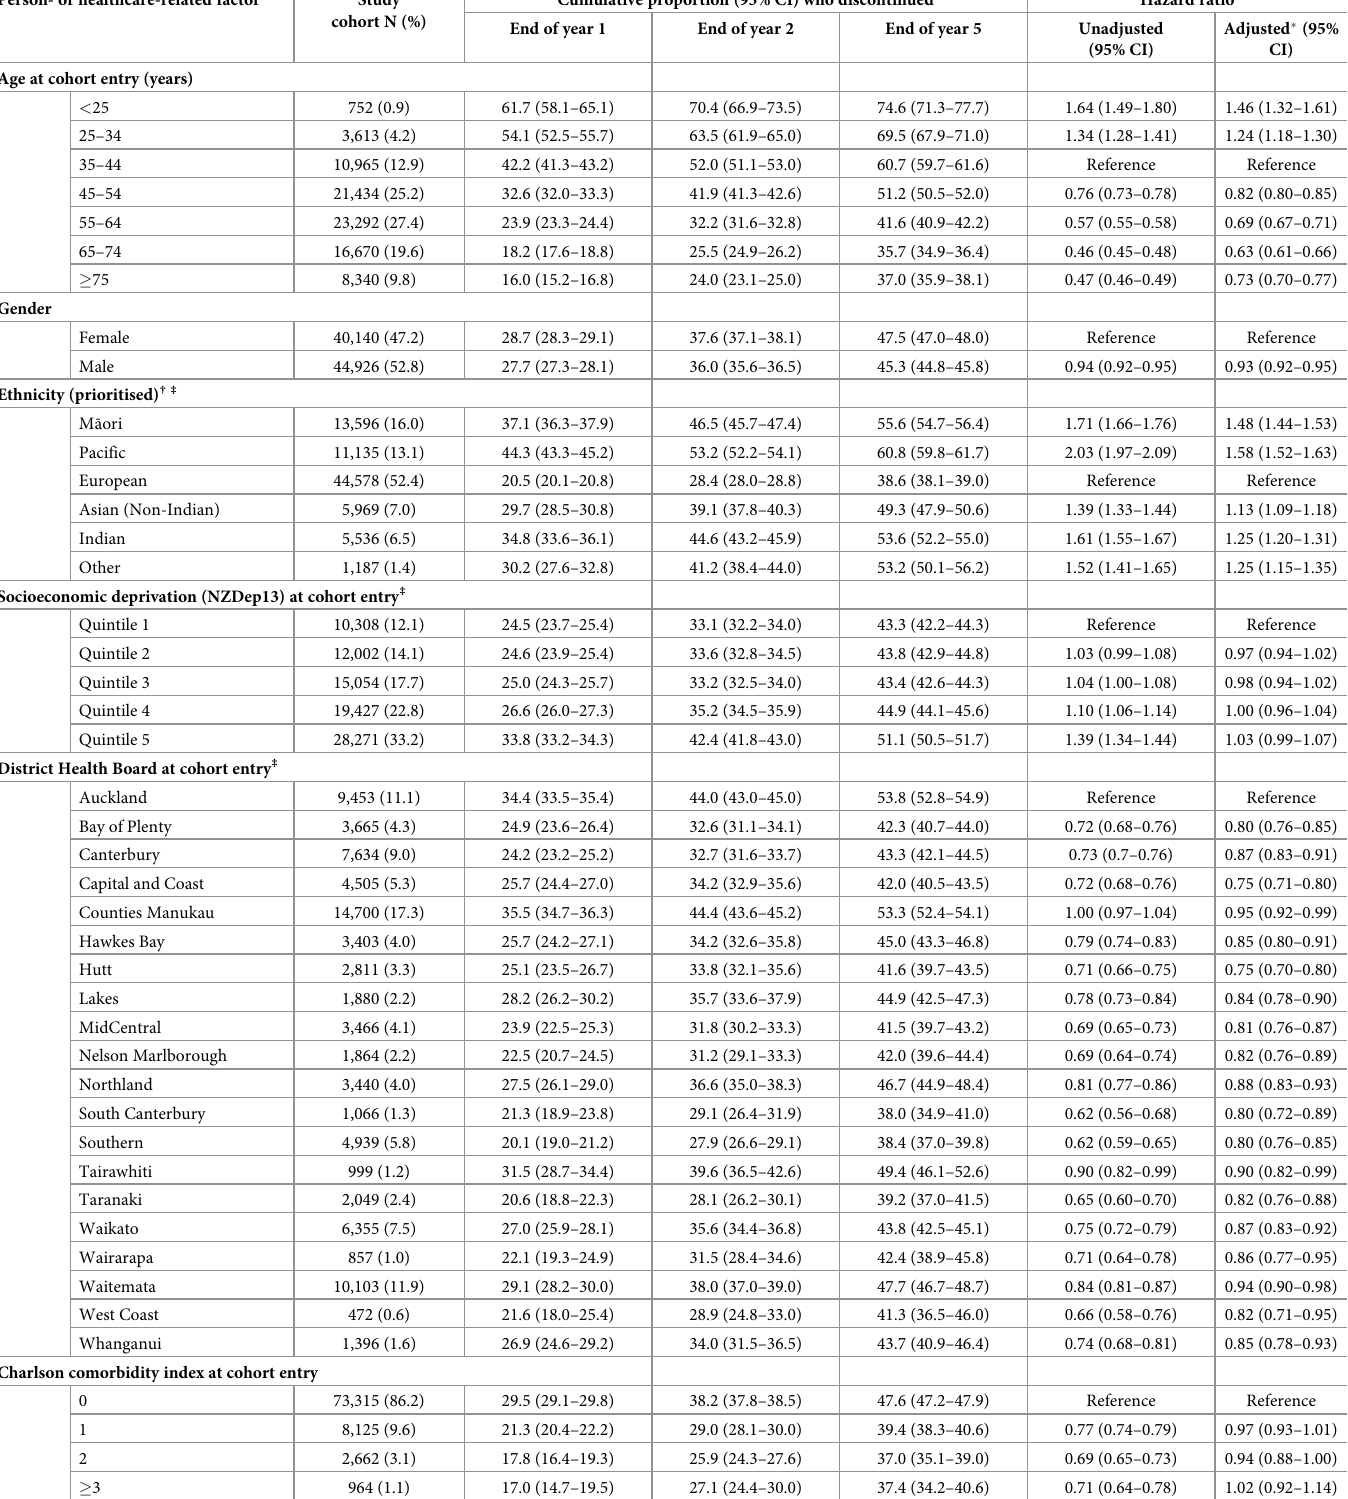
Table 1. Comparison of cumulative proportions who discontinued metformin monotherapy at least once by person- and healthcare-related